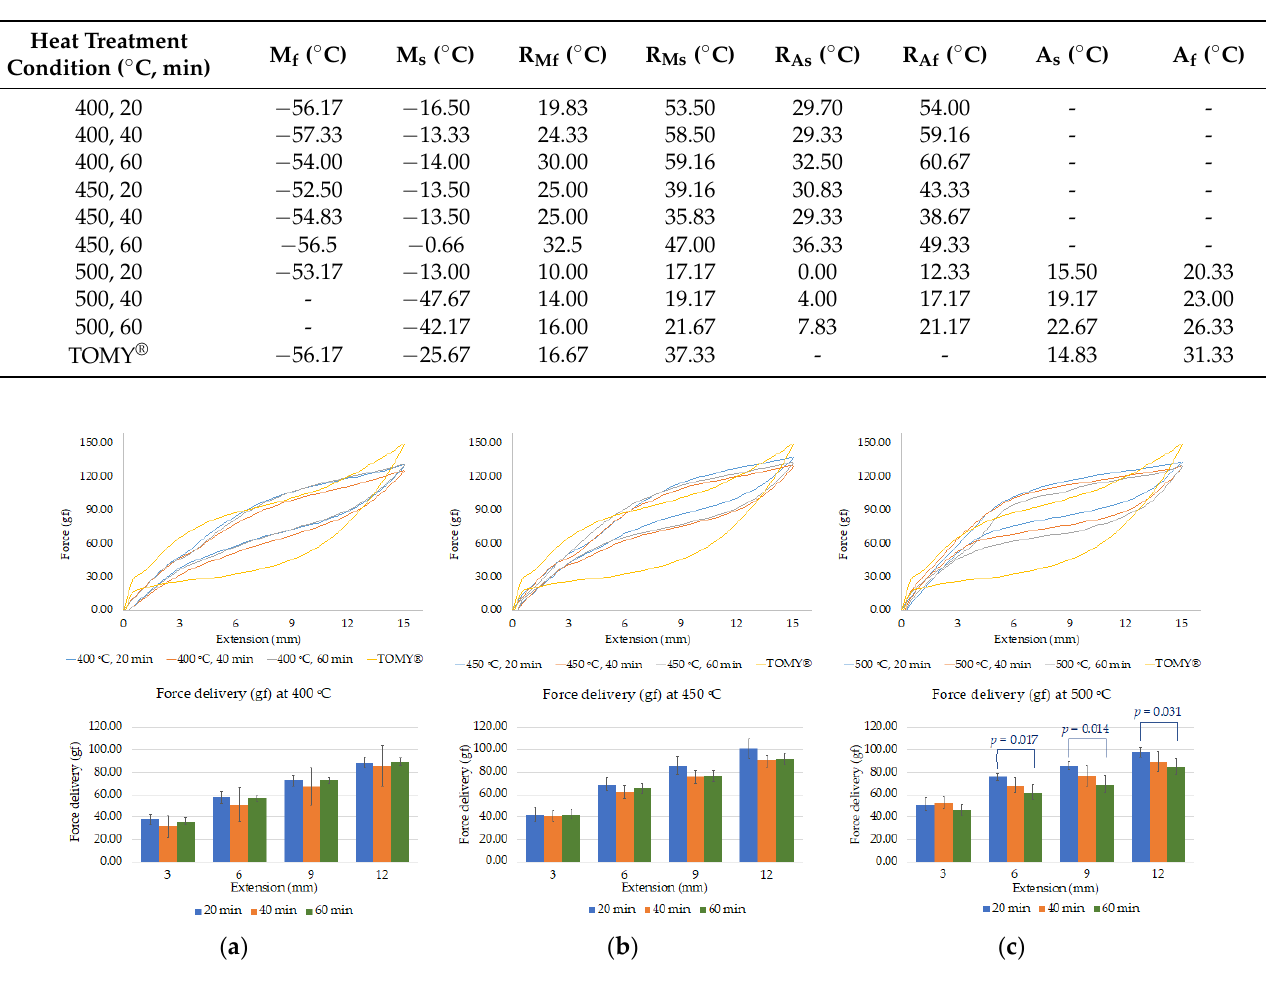
Figure 4. Superimpose of load-extension curves of custom-made closed coil springs under different heat treatment conditions with commercial NiTi closed coil springs (TOMY ® ): ( a ) at a constant temperature (400 °C) with various durations; ( b ) at a constant temperature (450 °C) with various durations; ( c ) temperature (500 °C) with various durations.